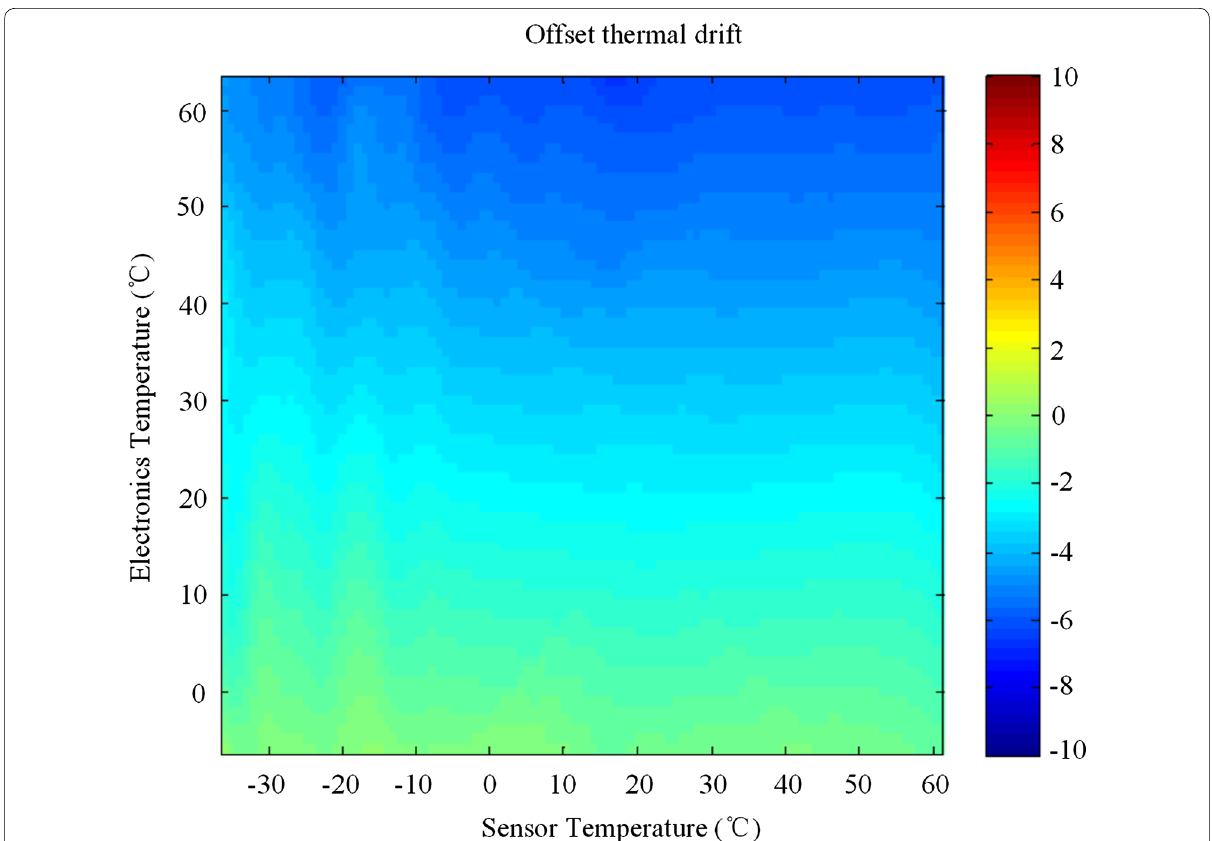
Fig. 8 Offset thermal drift (in nT) as a function of sensor temperature and electronics